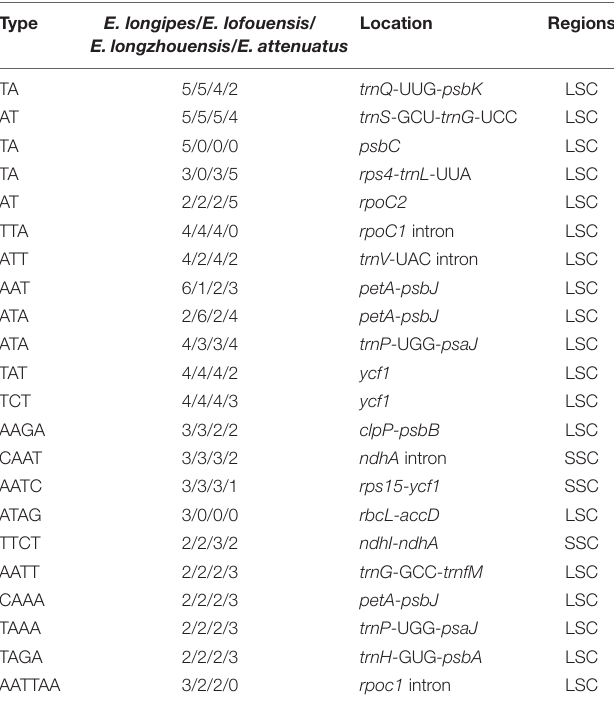
TABLE 3 | The polymorphic simple sequence repeats in